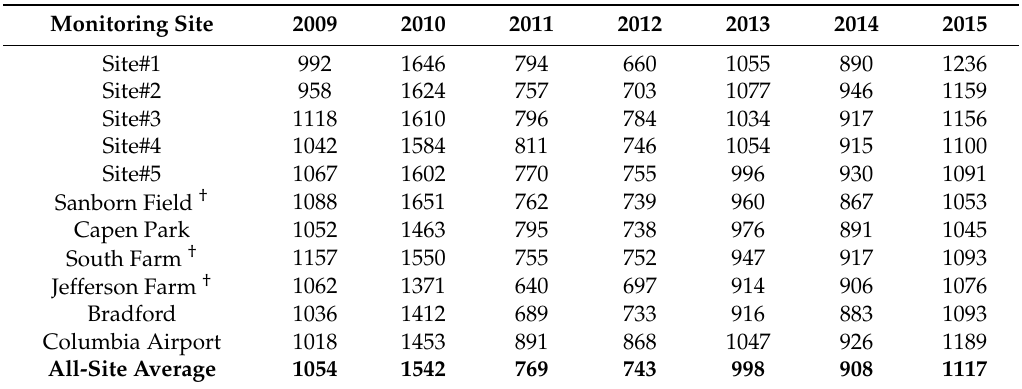
Table 4. Annual total precipitation (mm) directly measured at 11 monitoring sites during the water years from 2009 to 2015 located in Boone County, Missouri, USA.